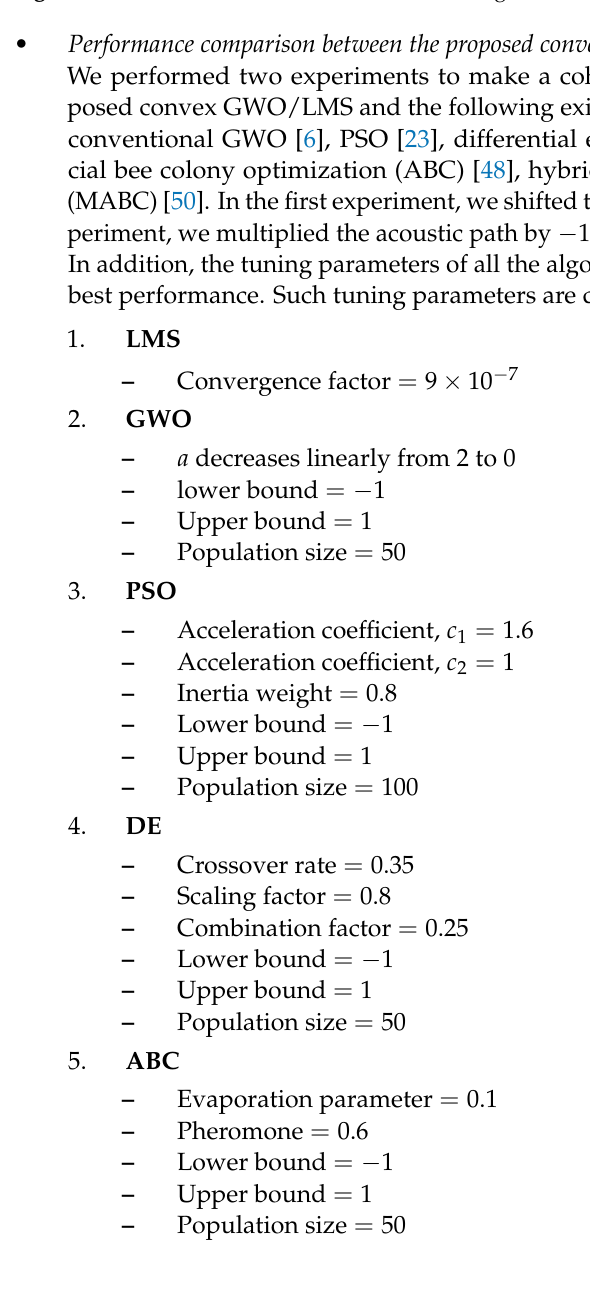
Figure 6. ERLE for different numbers of search agents P